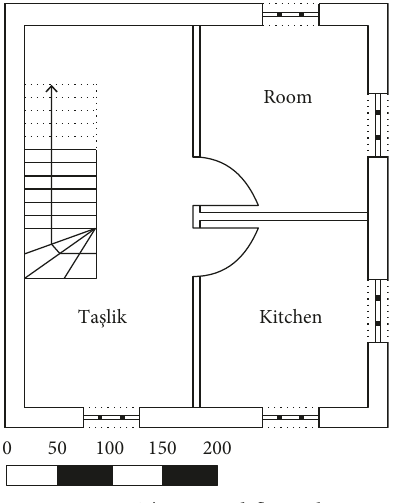
Figure 3: The ground floor plan.